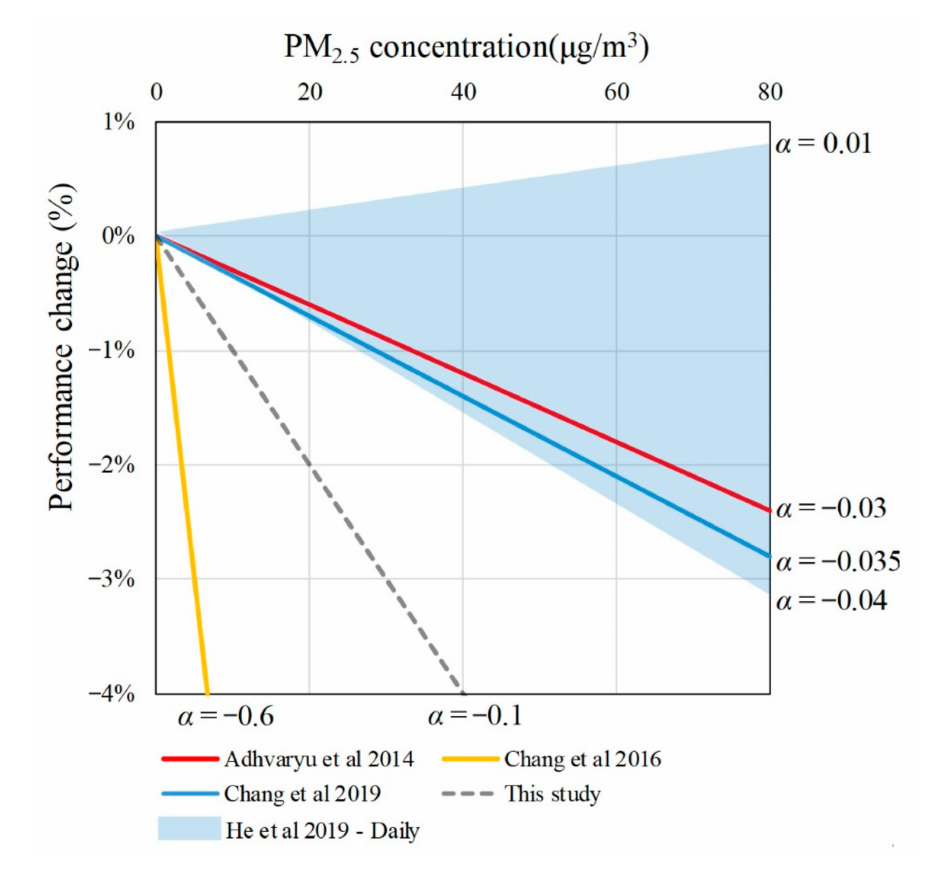
Figure 10. Comparison of the relationship between PM 2.5 concentration and performance